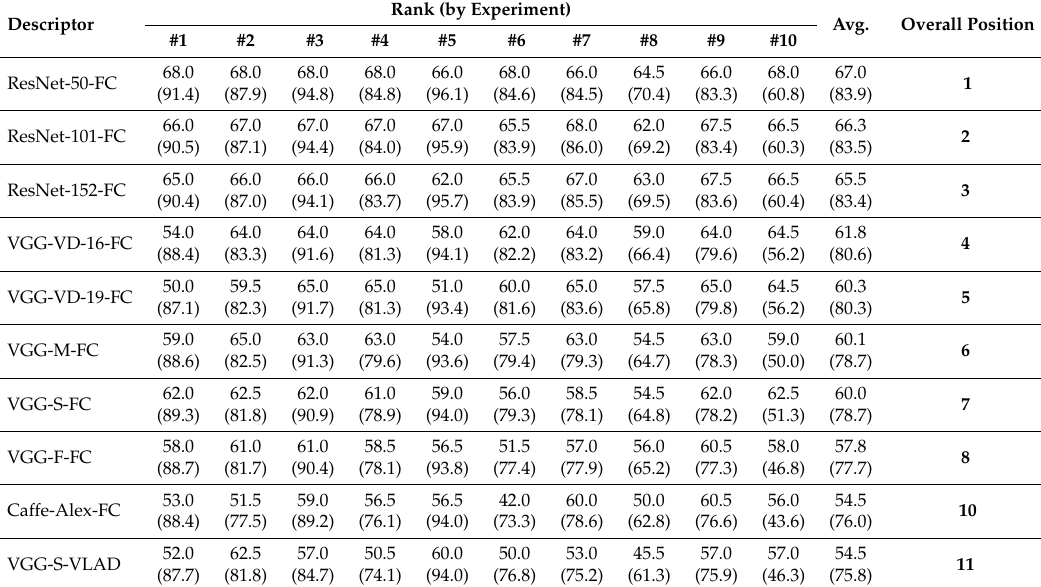
Table 5. CNN-based descriptors: relative performance of the best ten methods at a glance. For each method, the columns from #1–#10 show the rank (first row) and average accuracy (second row, in parentheses) by experiment. The next to last column reports the average rank and accuracy over all the experiments and the last column the overall position in the